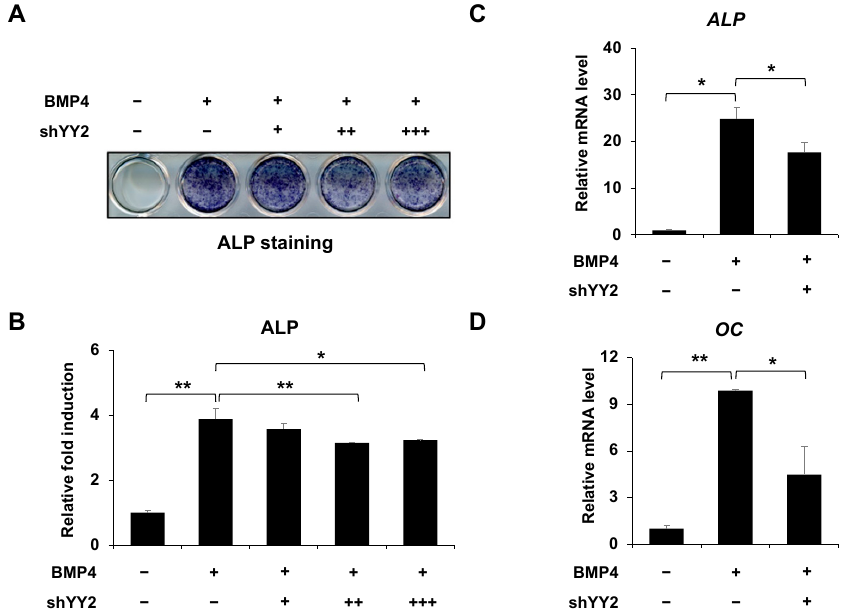
Figure 2. Knockdown of YY2 attenuates osteoblast differentiation. ( A , B ) Knockdown of YY2 reduced osteoblast differentiation. ALP staining and quantitative analysis of ALP activity after shControl (pSuper-empty vector) or increasing amounts of shYY2 transfected C2C12 cells treated with or without BMP4 for 72 h. ( C , D ) Knockdown of YY2 decreased the expression of osteoblast markers such as ALP and OC. C2C12 cells were transfected with shControl (pSuper-empty vector) or shYY2 and then stimulated with BMP4 for 48 h. The expression of ALP and OC is analyzed by RT-qPCR. Data are expressed as mean ± SEM of at least three experiments. * p < 0.05, and ** p < 0.01.